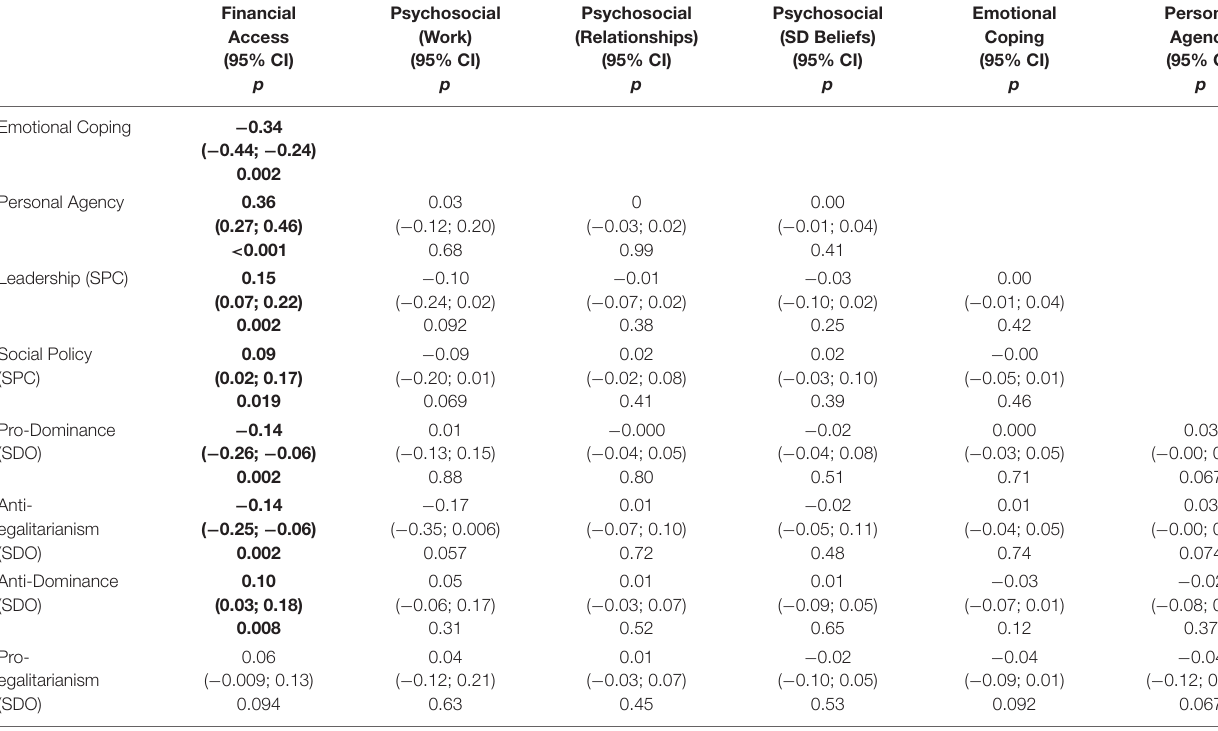
TABLE 5 | Indirect effects for the mediation SEM Model